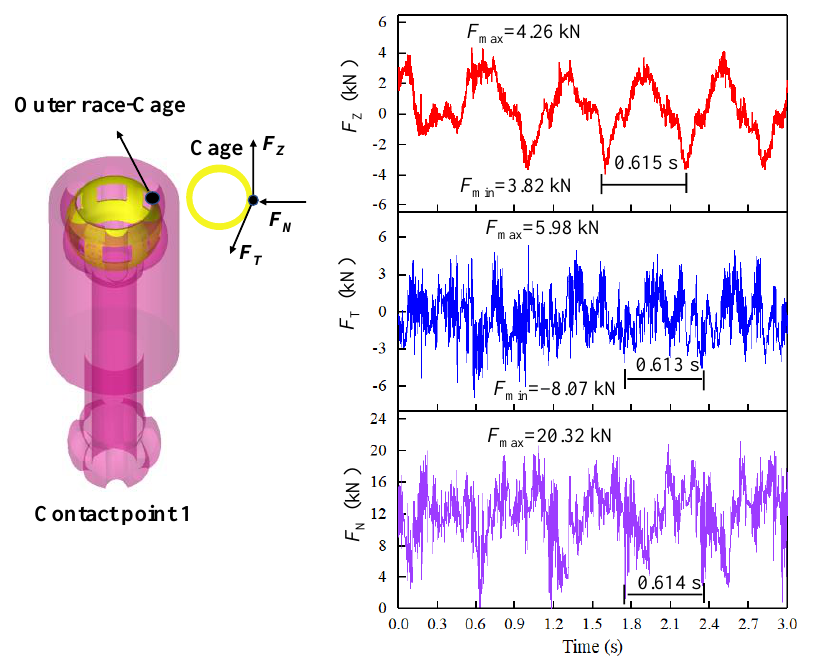
Figure 8. The variation of contact force between outer race and cage.